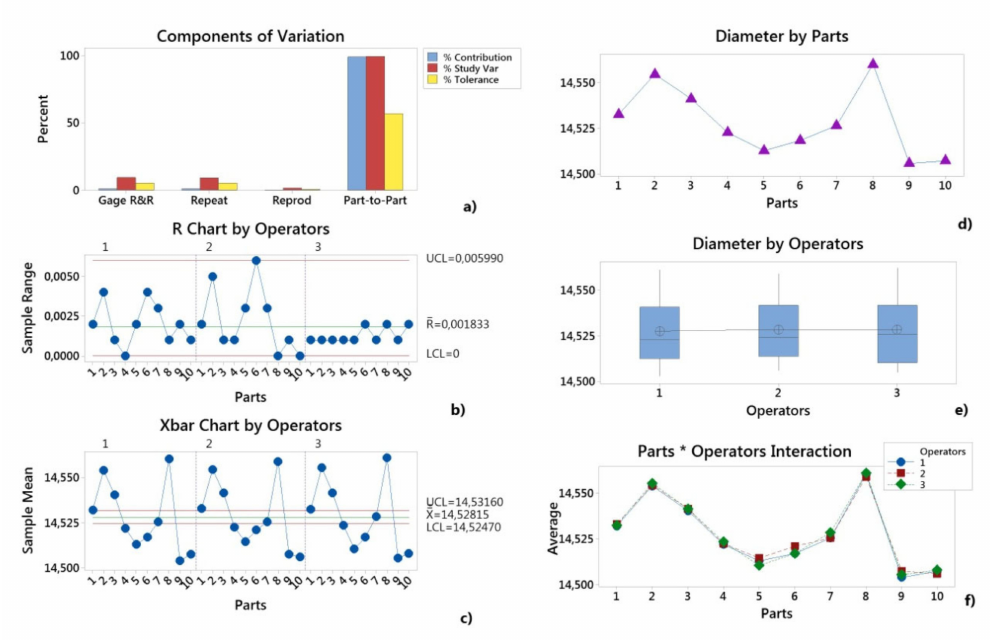
Figure 5. Gage R&R (ANOVA) report for diameter (D): ( a ) Components of Variation graph; ( b ) R Chart by Operator; ( c ) Xbar Chart by Operators; ( d ) By Parts graph; ( e ) By Operators graph; ( f ) Parts * Operators interaction.